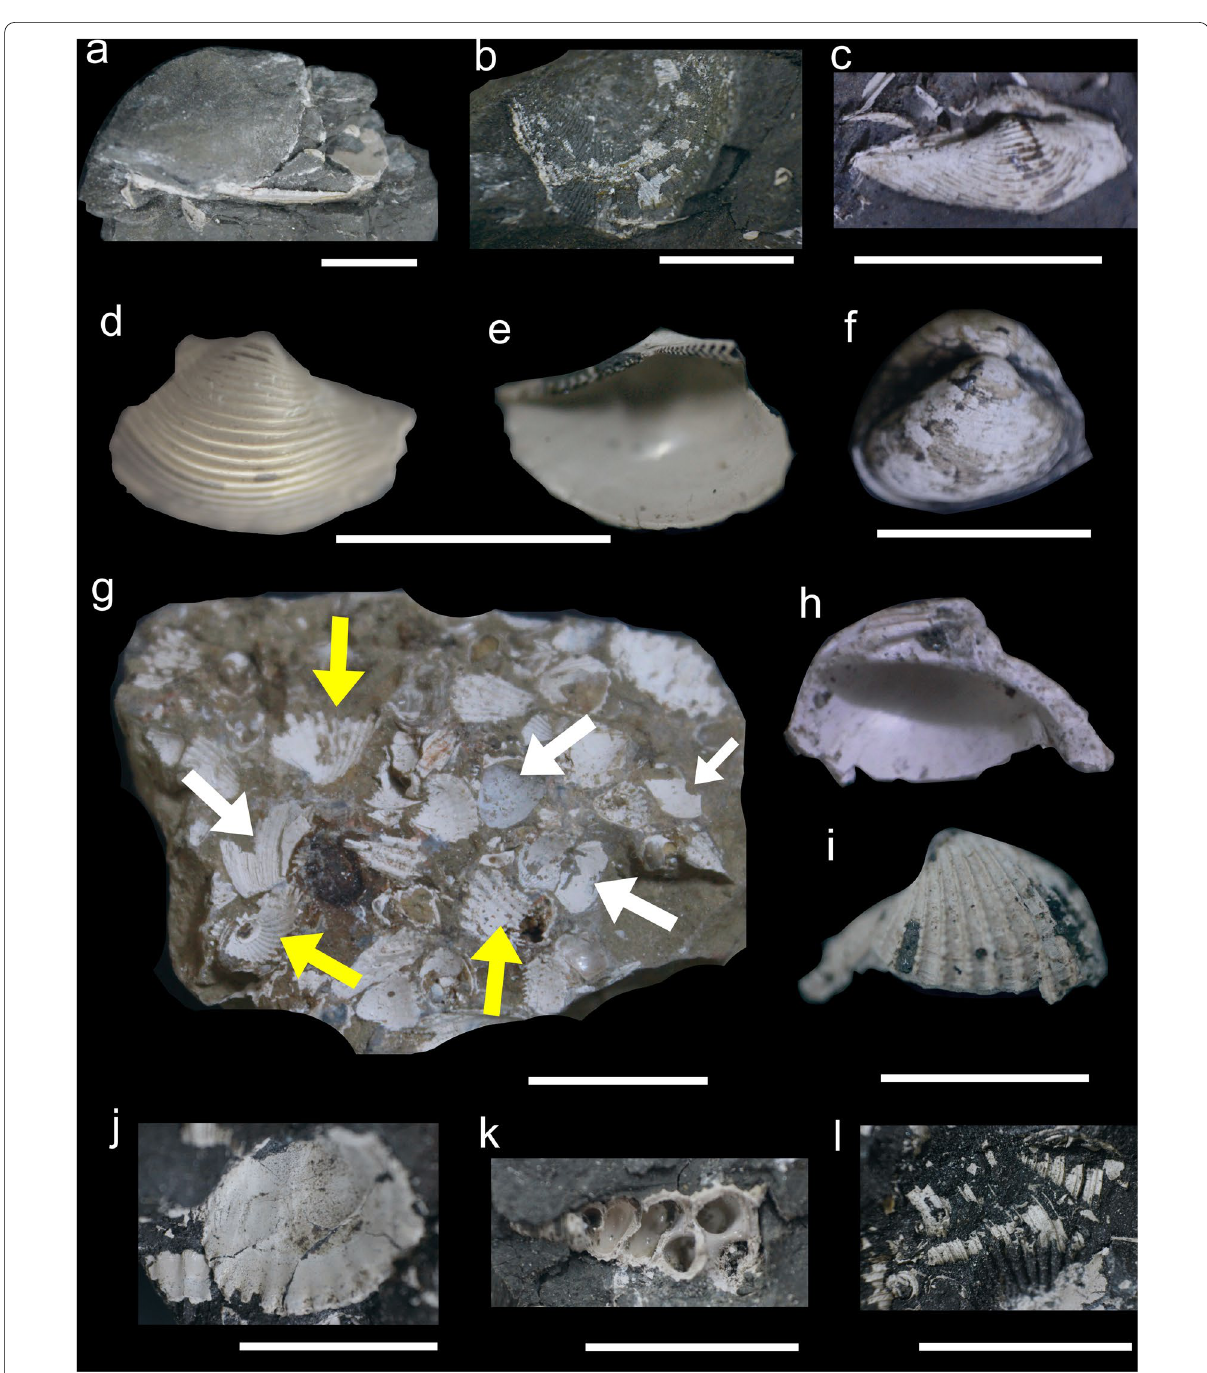
Fig. 5 Mollusc fossils from unit 3 a Broken shell of Pteria sp. b Partially preserved Anomia sp. c – e Nuculana sp. c within green shale, d external view of left valve, e internal view of left valve. f Articulated specimen of Caestocorbula sp. g Aphrodina sp. (white arrow) and Claibornicardia sp. (yellow arrow) in shell limestone h – j Claibornicardia sp. h internal view of left valve, i external view of left valve, j internal view of right valve. k , l Turritella sp. Scale bars 10